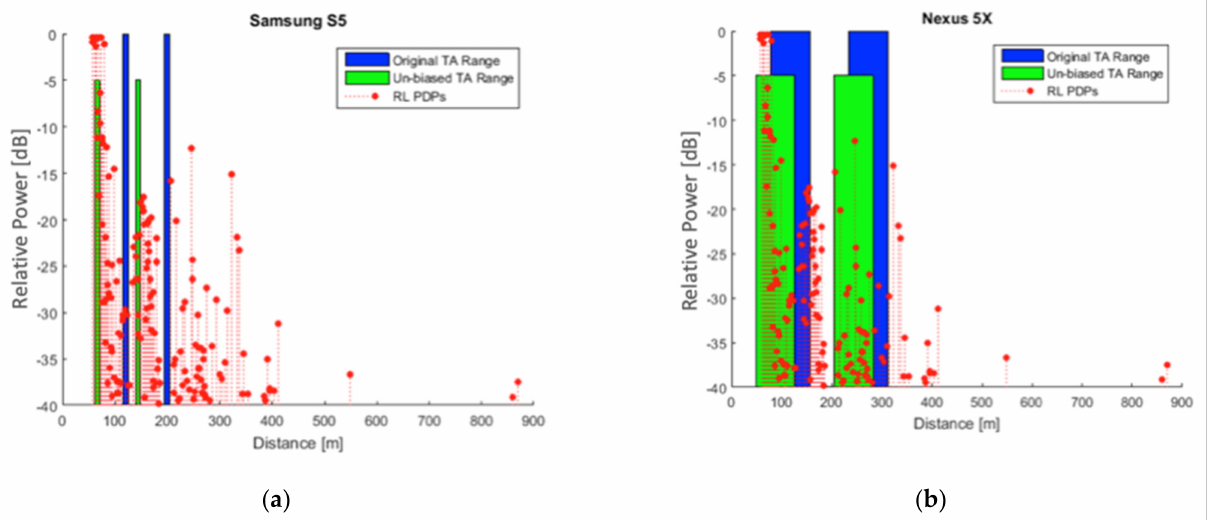
Figure 7. Comparison between TA measurements in San Jos é and Power-Delay Profiles generated by DED-RL ( a ) for Samsung S5 device and ( b ) for Nexus 5X